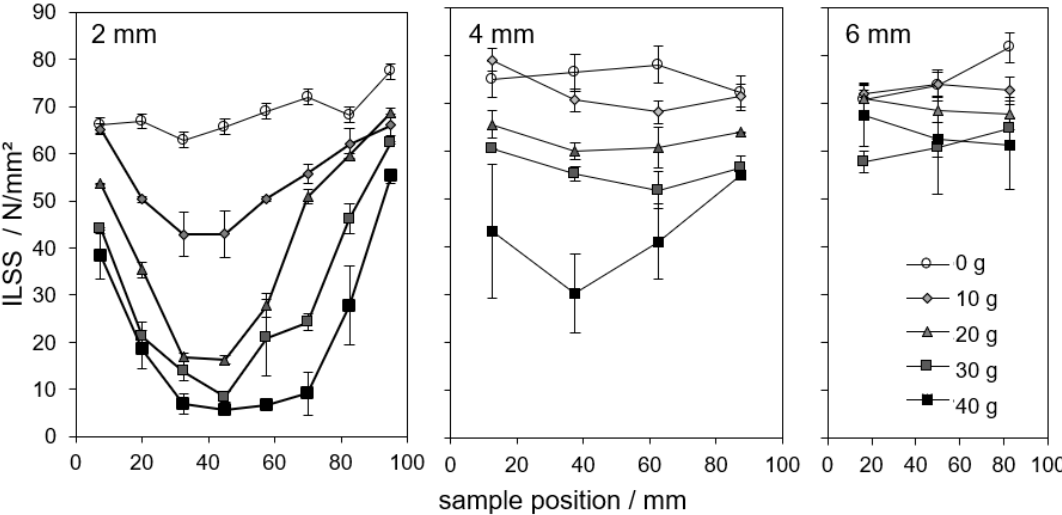
Figure 12. Representative distribution of interlaminar shear strength (ILSS) after impact of various amounts of fire accelerants on 2, 4, and 6 mm thick 8552/IM7 samples (with integrated copper mesh, horizontally aligned).